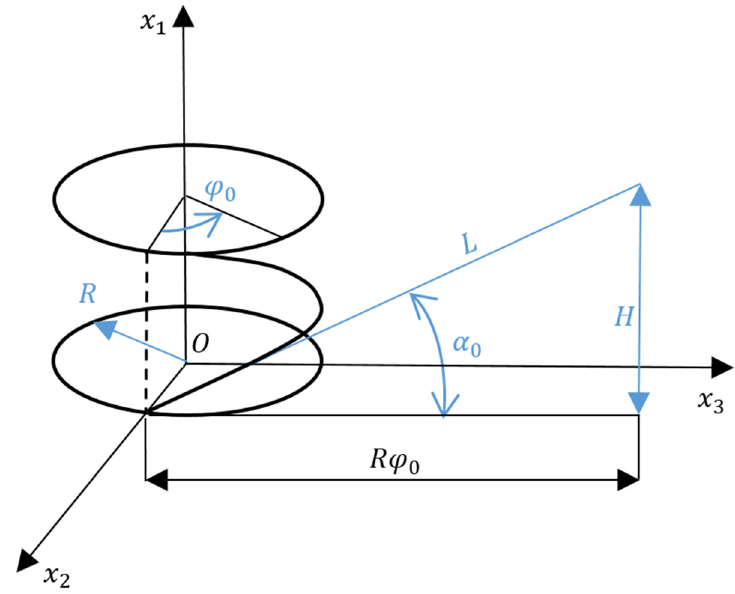
Figure 3. Scheme for calculating the helix.